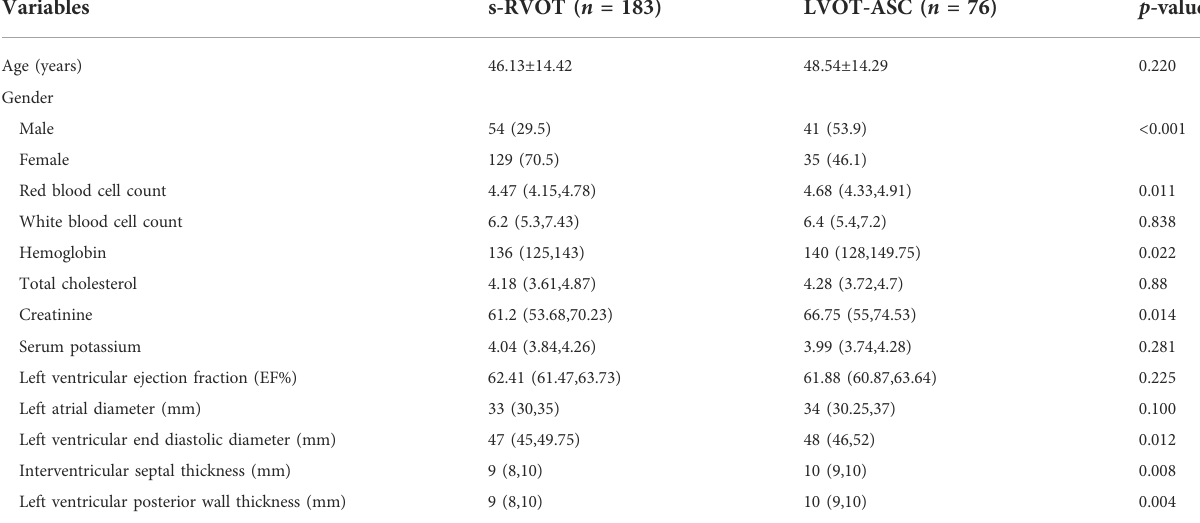
TABLE 1 Comparison of the baseline characteristics betweenw the s-RVOT and LVOT-ASC groups.